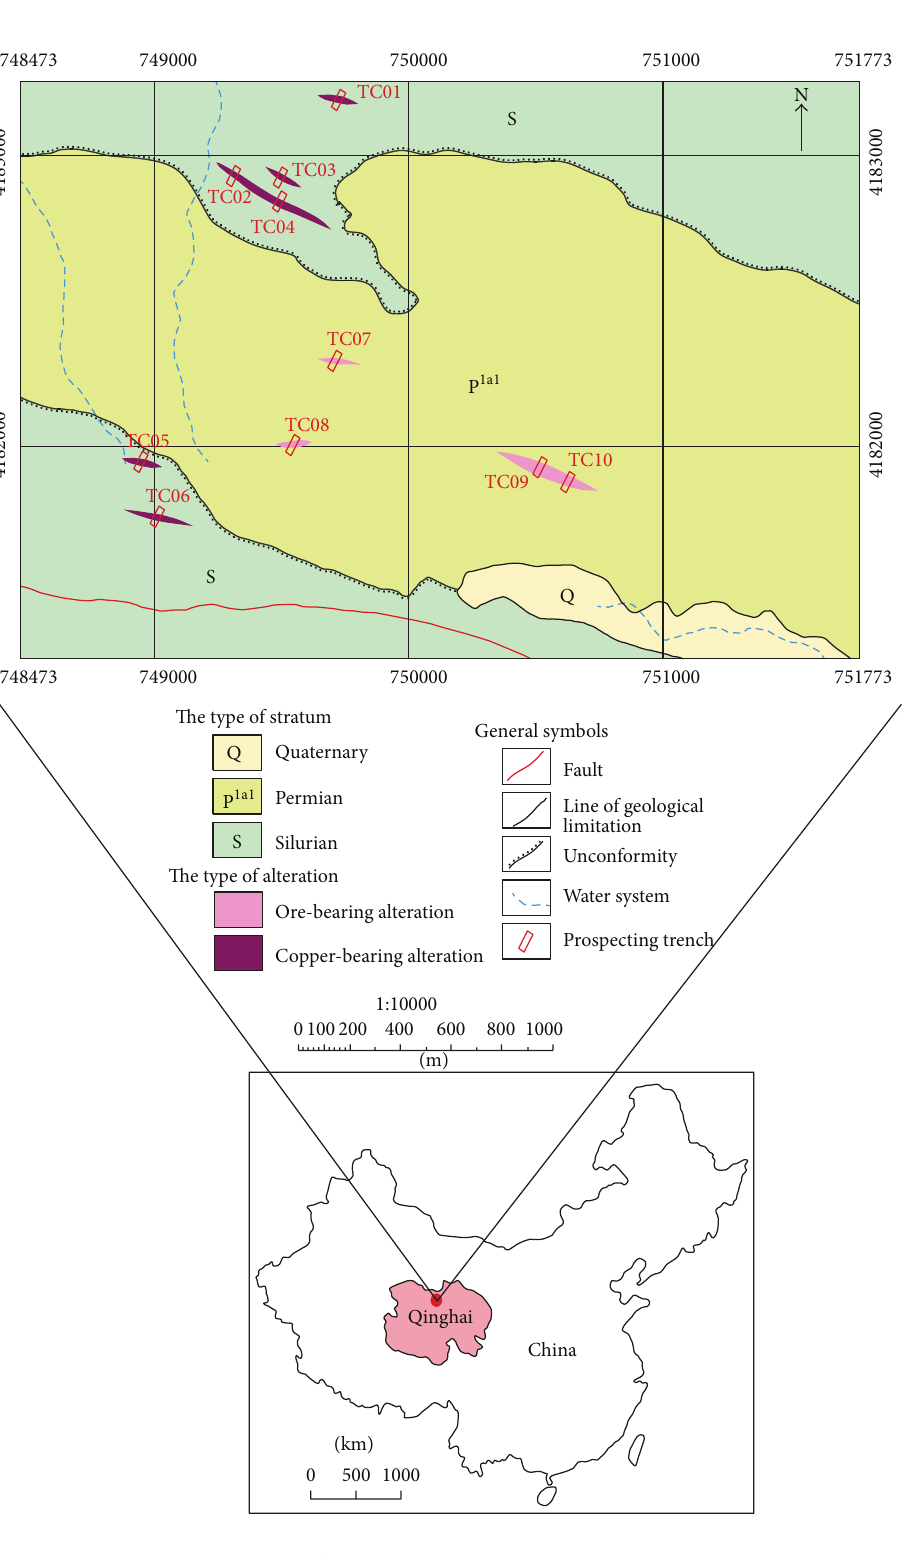
Figure 2: Simplified geological map and location map of the study area with